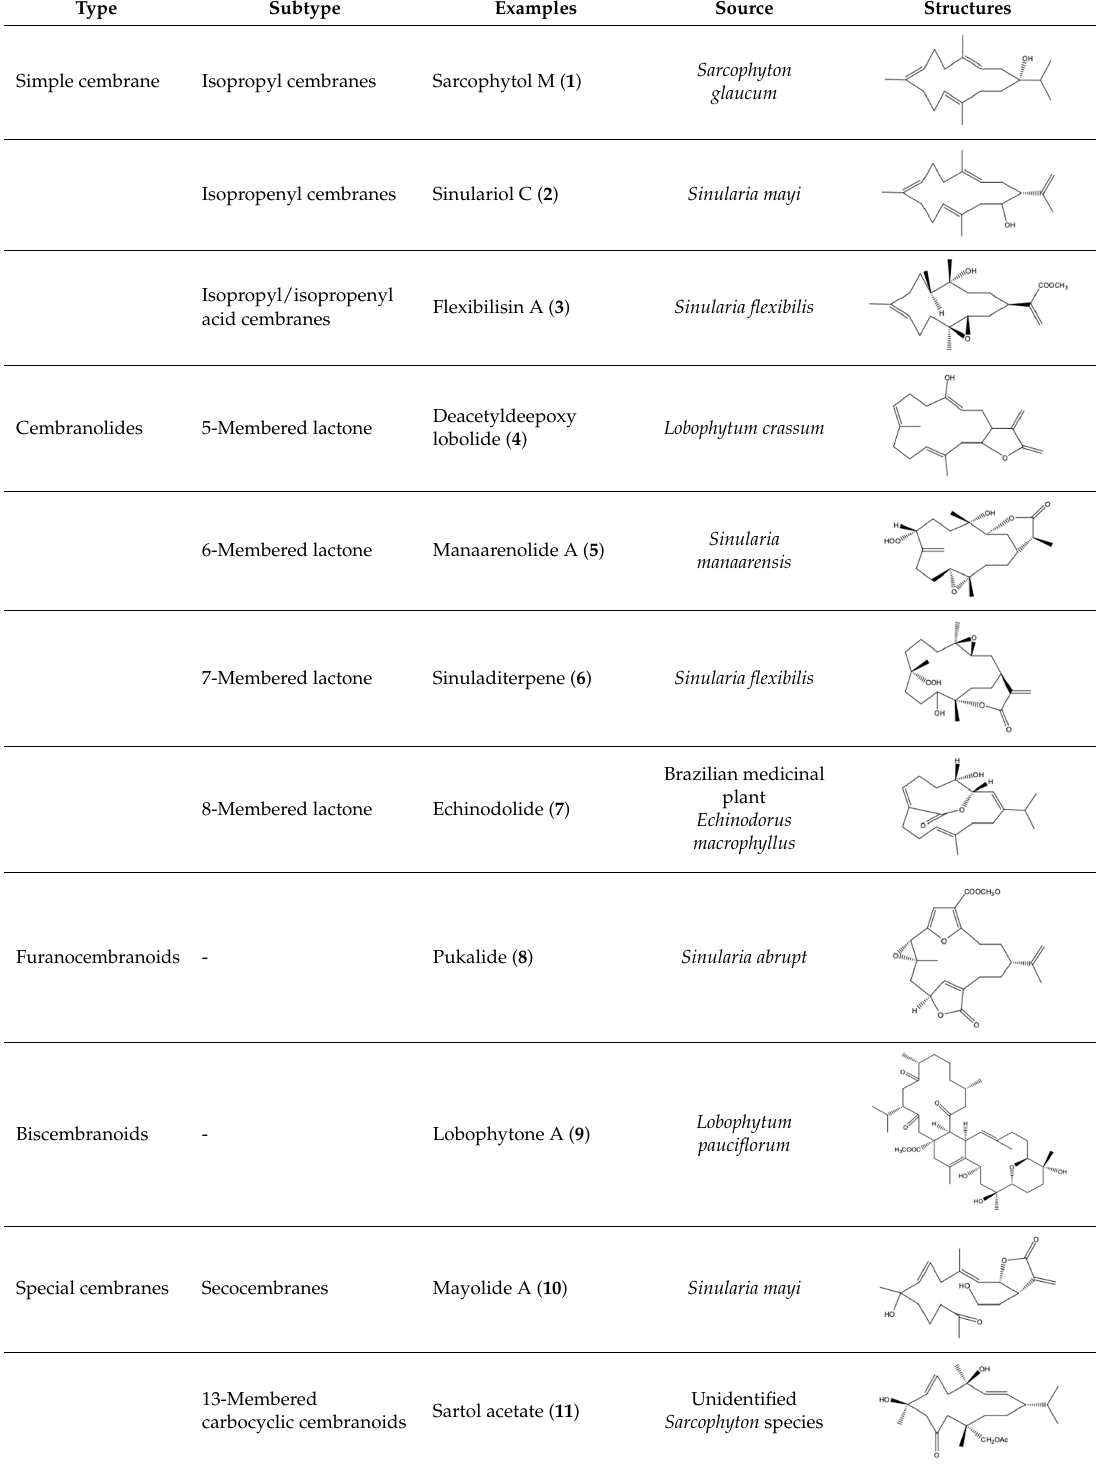
Table 1. Classification of cembrane diterpenoids.